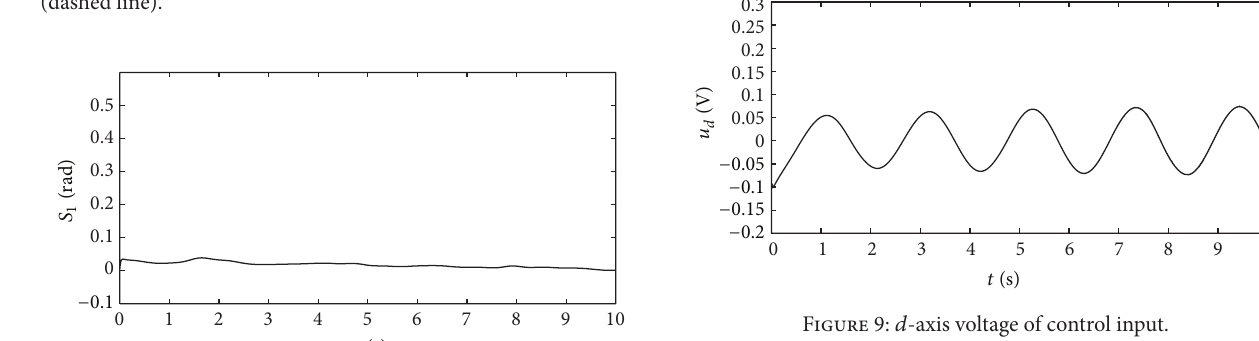
Figure 6: Output 𝑥 1 (solid line) follows desired trajectory 𝑦 𝑟 (dashed line).